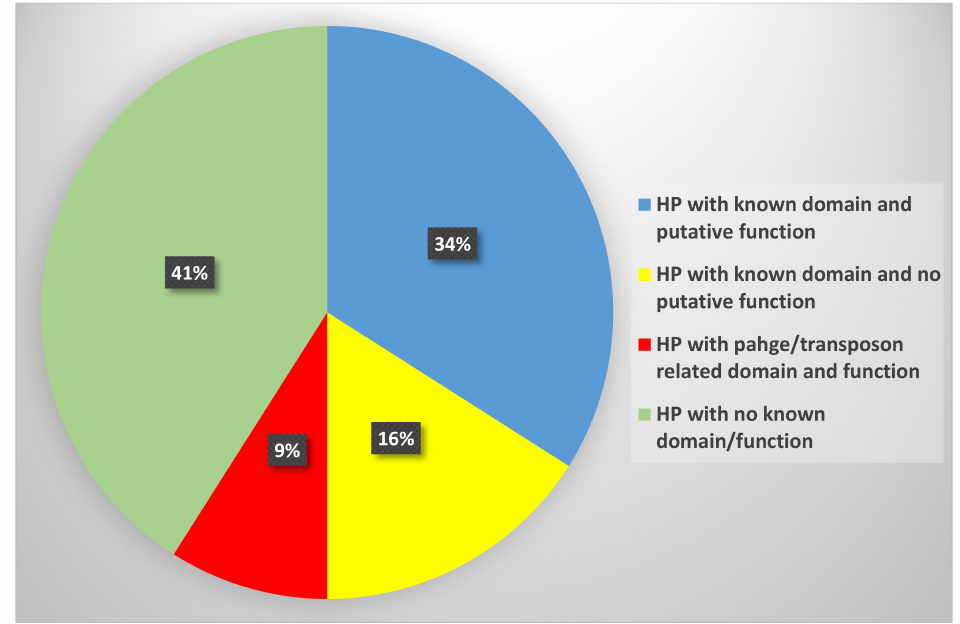
Figure 3. The distribution of 721 HPs present in the Shigella flexneri 1c genome. Sequence analysis of the 721 HPs was carried out using four bioinformatics tools, namely CDD-BLAST, Pfam, InterProScan, and SCANPROSITE. This resulted in 293 HPs (41%) with no specific conserved domains and the remaining 428 HPs, for which specific domains were assigned. These consisted of 246 HPs with both known domain and putative function, 119 HPs with only known domains, and 62 HPs with domains related to bacteriophage genes like tail / head / assembly proteins or the transposon genes.